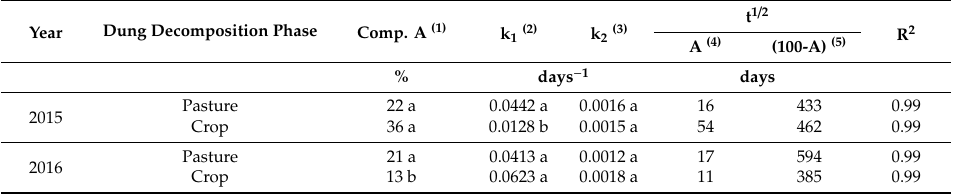
Figure 1. Residual dry matter (DM) of sheep dung at different decomposition phases (pasture and crop phases) in 2015 ( a ) and 2016 ( b ) in a no-till integrated soybean-sheep production system (average of low and moderate grazing intensities). Table 3. Parameters of the double exponential model for sheep dung decomposition rates influenced by decomposition phases and experimental years in a no-till integrated soybean-sheep production system. Results are the averages of low and moderate grazing